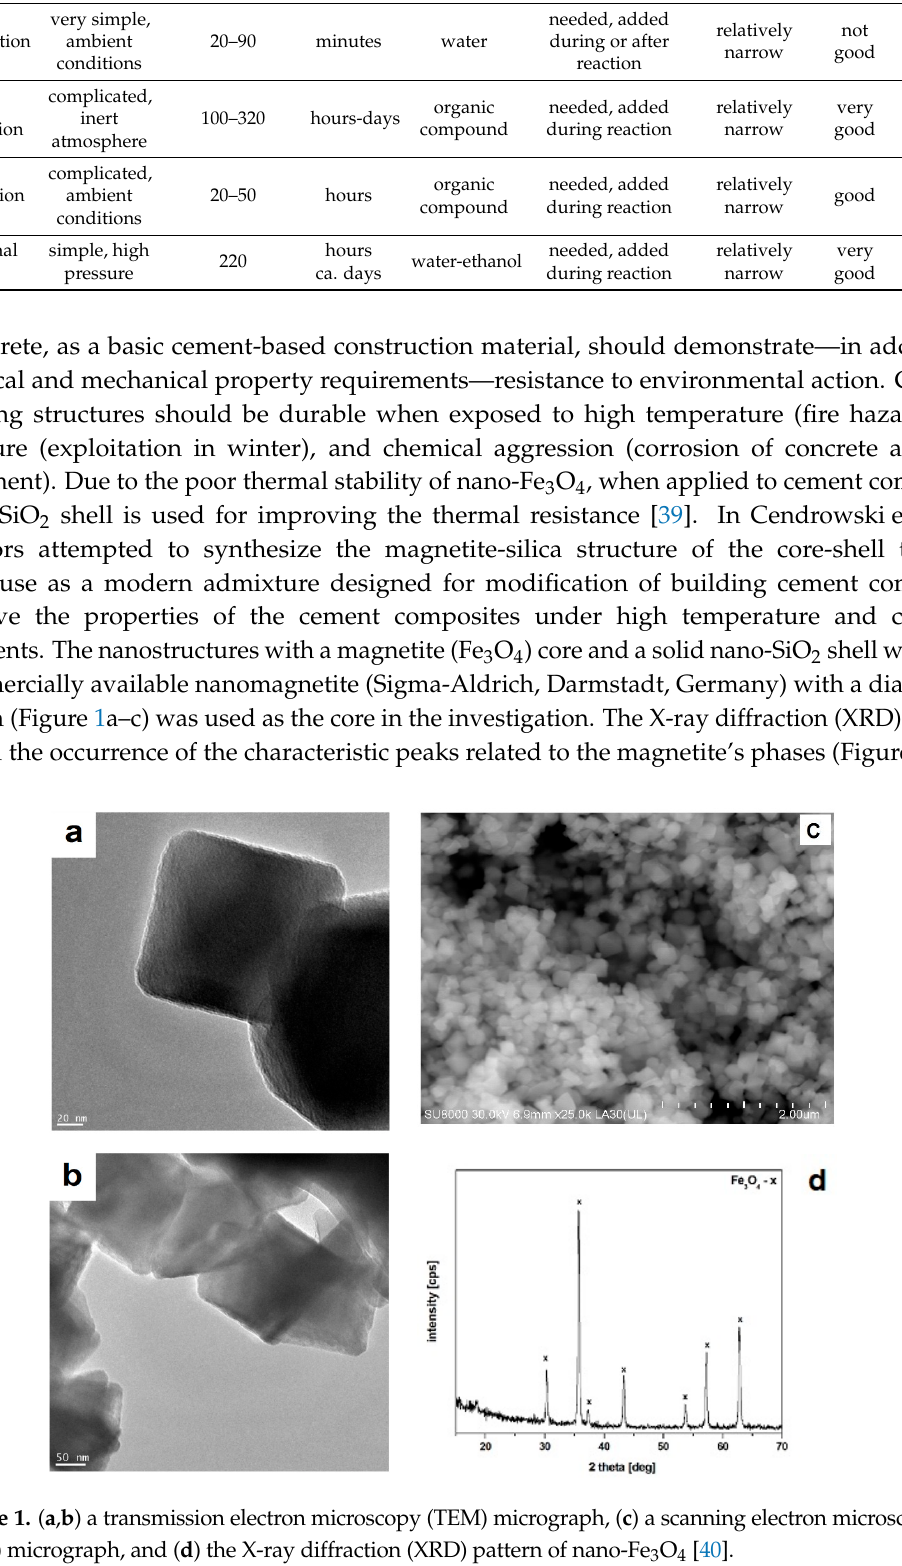
Table 1. A summary comparison of the synthesis methods [33].